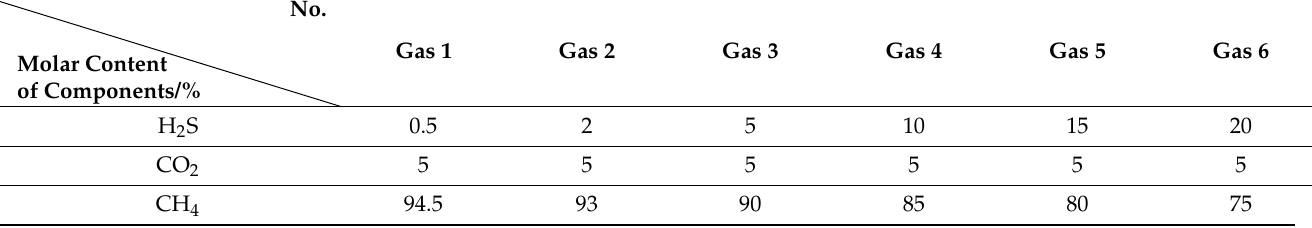
Table 2. The components of HSCNG